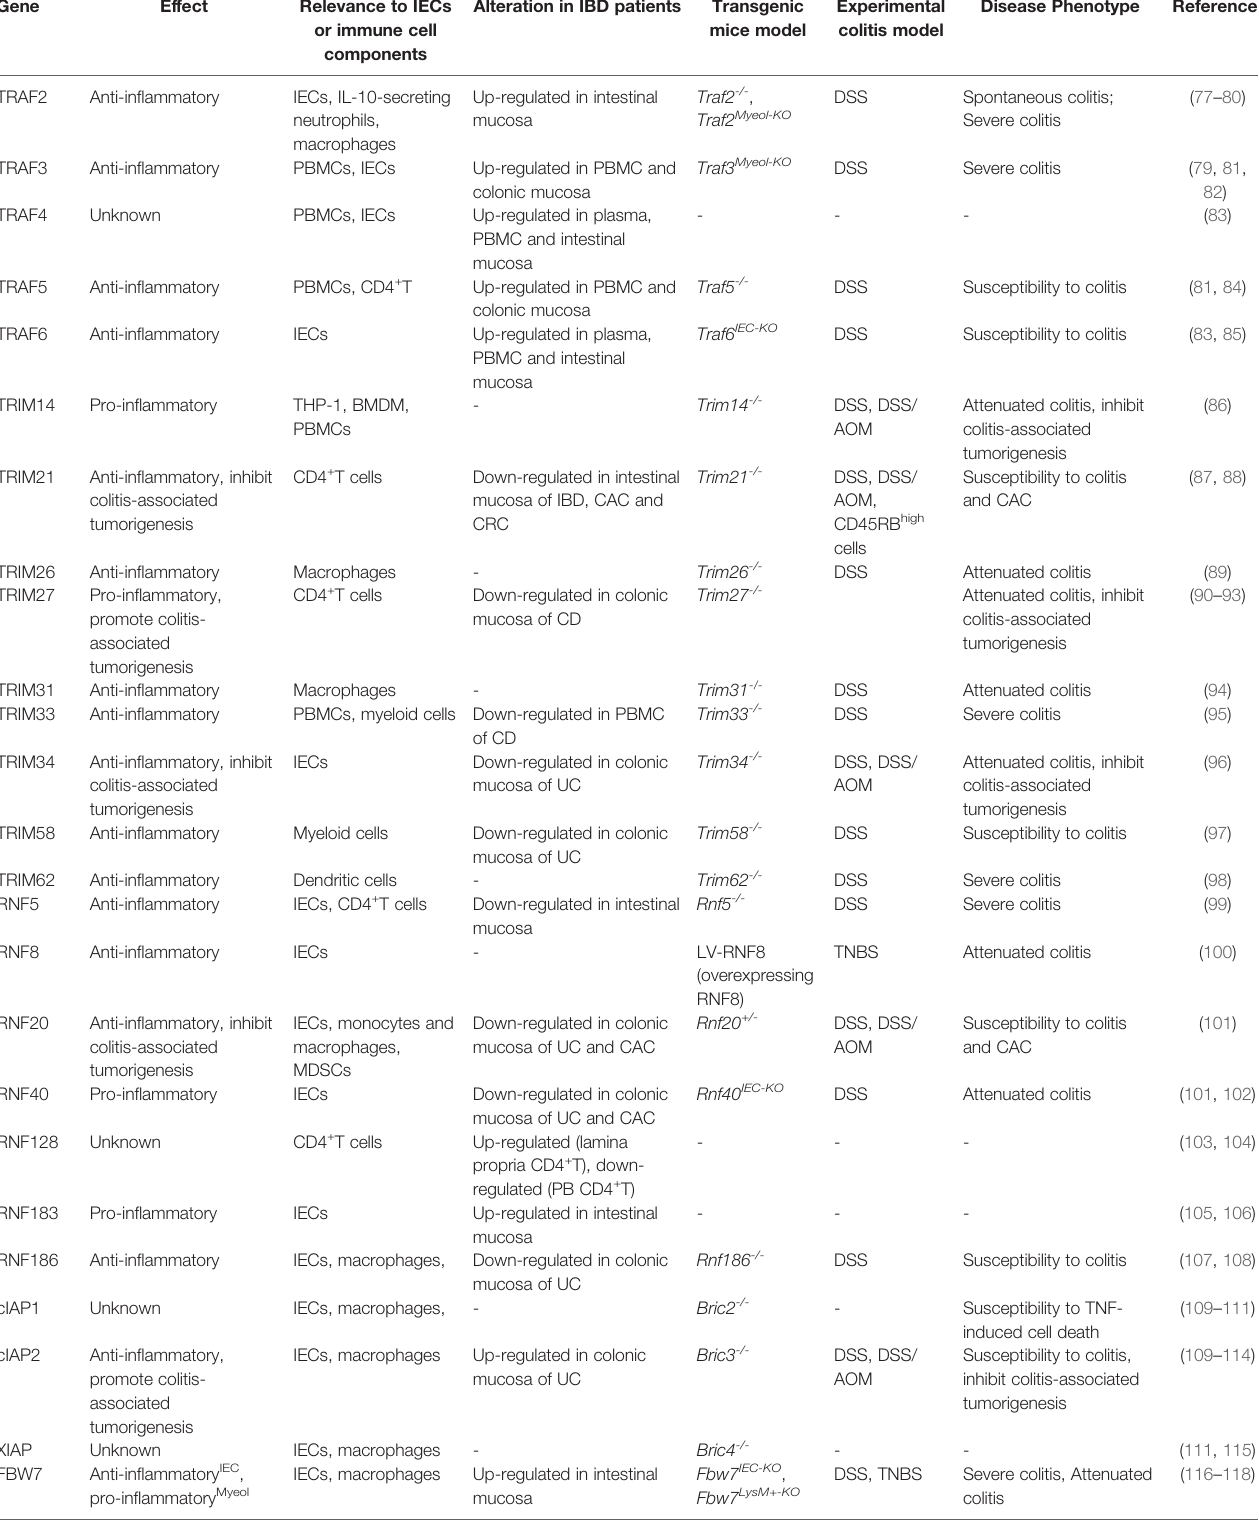
TABLE 1 | Role of E3 ubiquitin ligases in in fl ammatory bowel